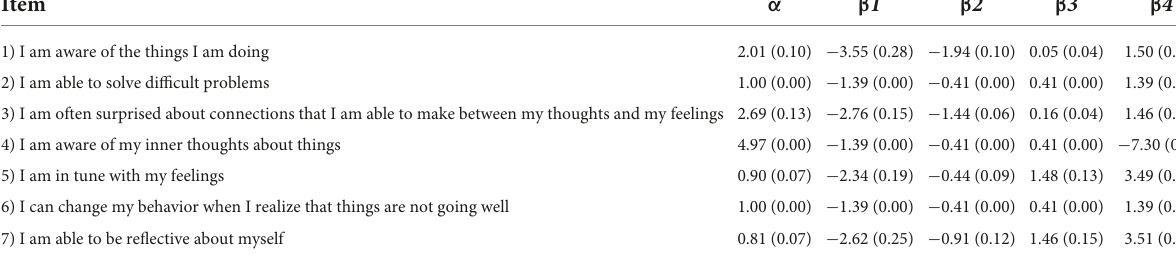
TABLE 6 IRT parameter estimates and standard errors for the IOS – Grade Response